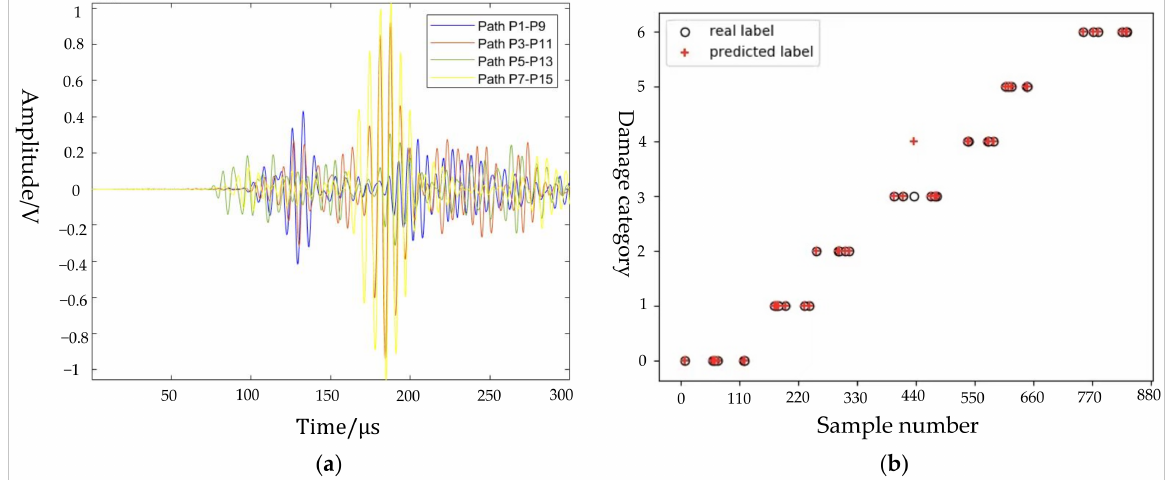
Figure 7. Identification of crack direction: ( a ) comparison of detection signals obtained from different paths for the same defect; and ( b ) scatter diagram of identification results of crack